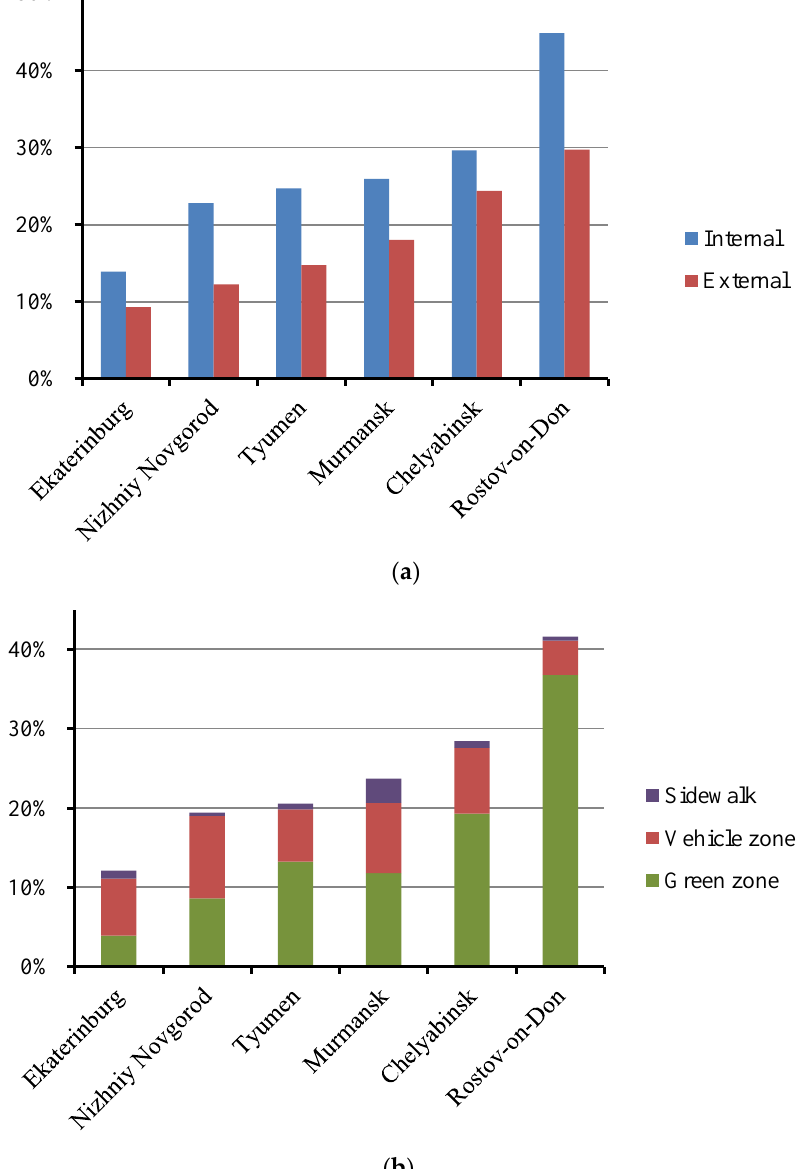
Figure 6. ( a ) Disturbed cover areas in courtyards and external parts of EURLs; ( b ) the share of disturbed cover areas on the site (excluding the area of roads), and the contribution of the main functional zones to the total area of damaged cover.